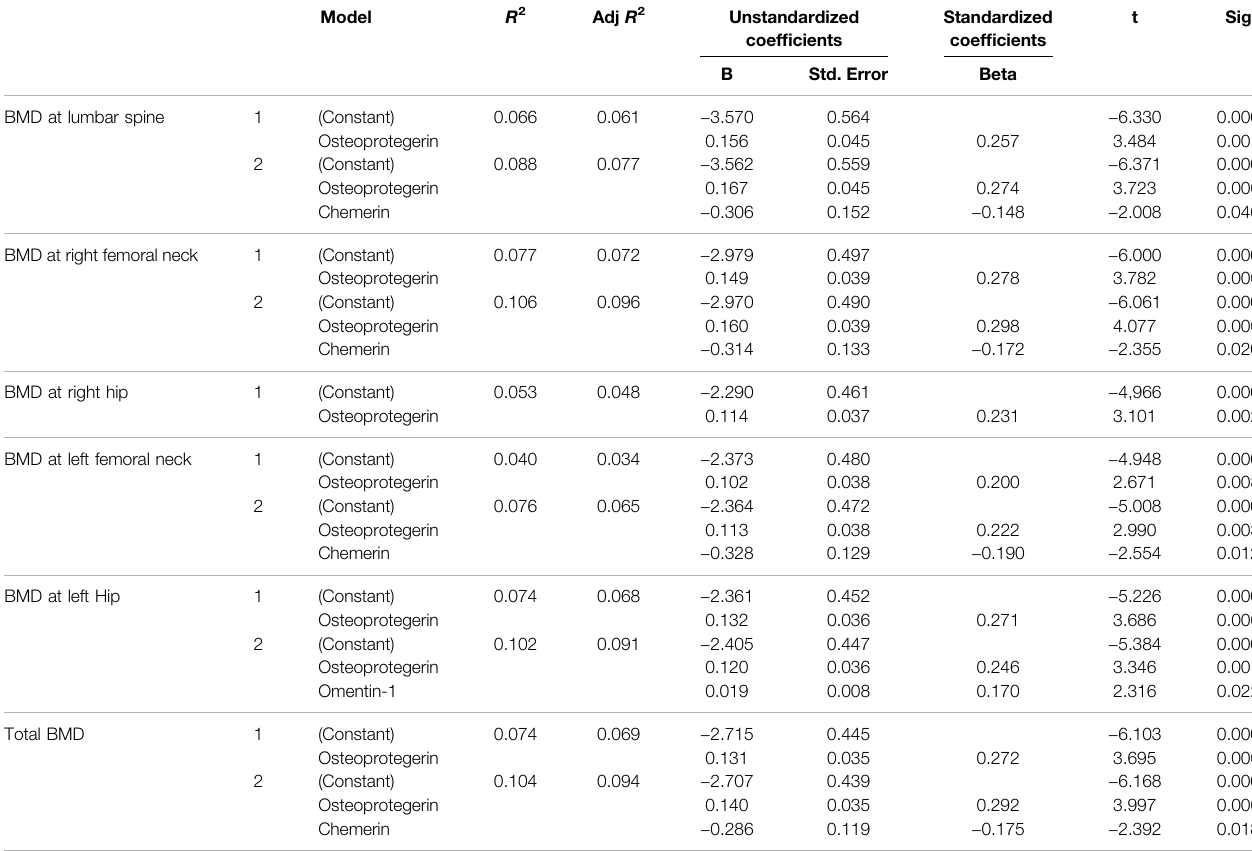
TABLE 3 | Multivariate linear stepwise regression analysis showing independent predictors of BMD at various